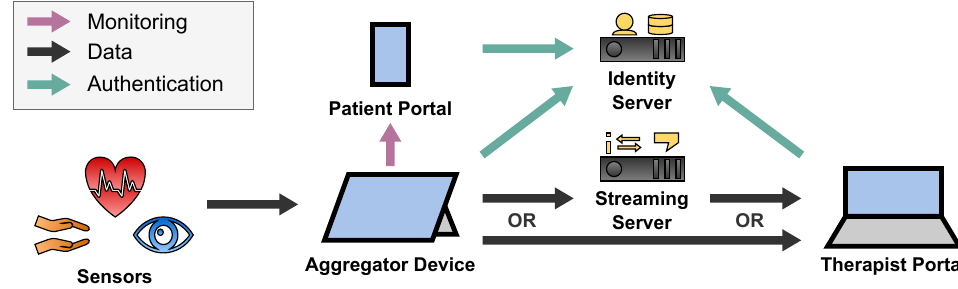
Figure 13. Streaming Architecture of the